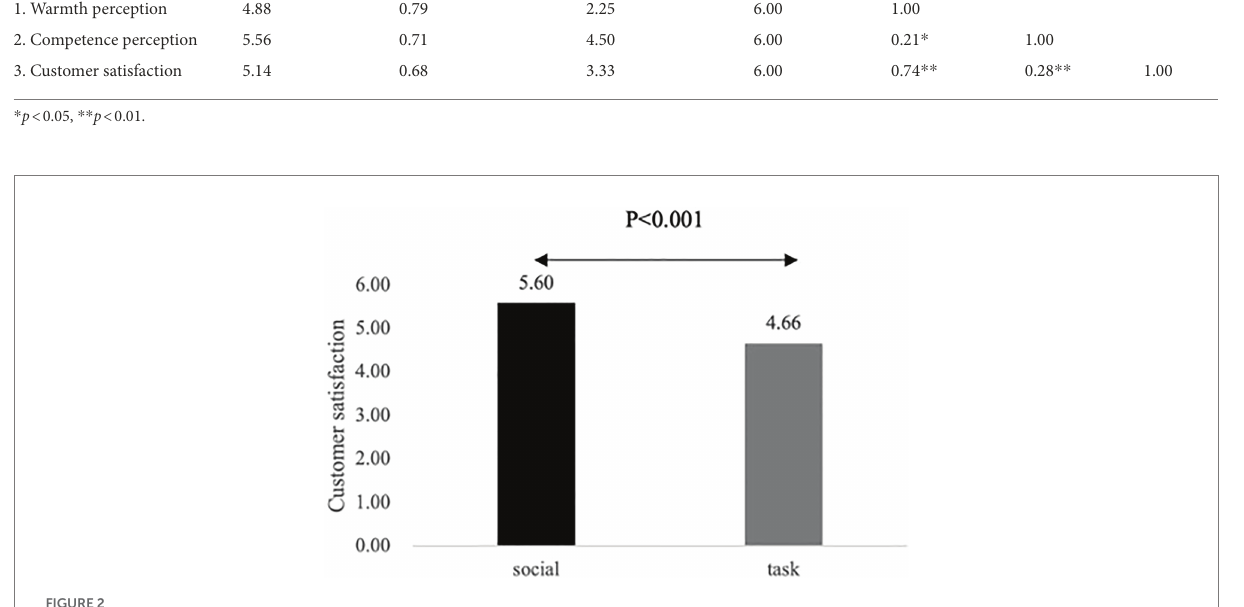
FIGURE 2 Mean values for customer satisfaction for Study